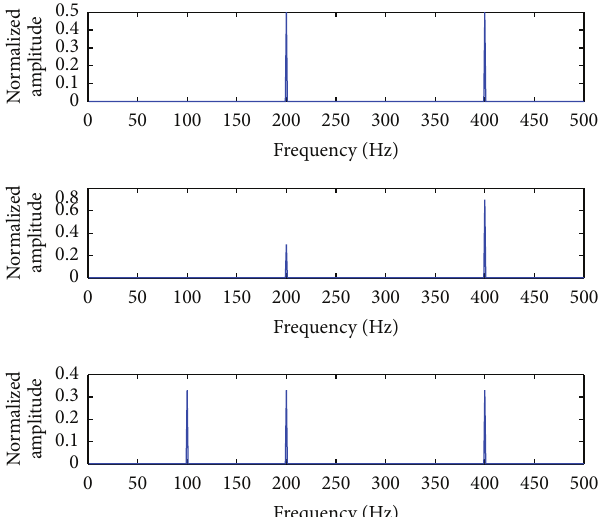
Figure 3: FRFs used as examples of the dependency of SE with the amplitude distribution. Their values of SE are 3.163, 3.108, and 3.443.